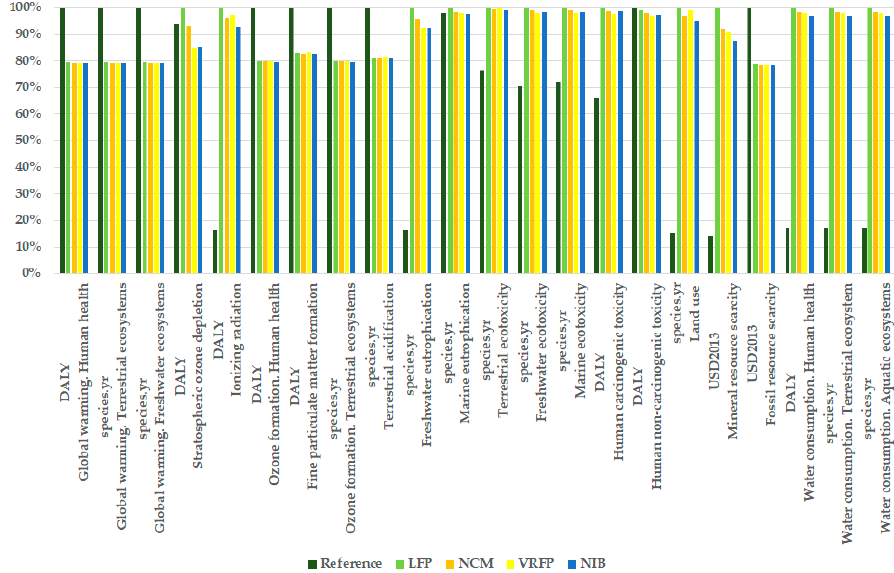
Figure 6. Impact characterization for the different batteries in the alternative scenario and for the reference case (ReCiPe 2016 method-Endpoint (H)).